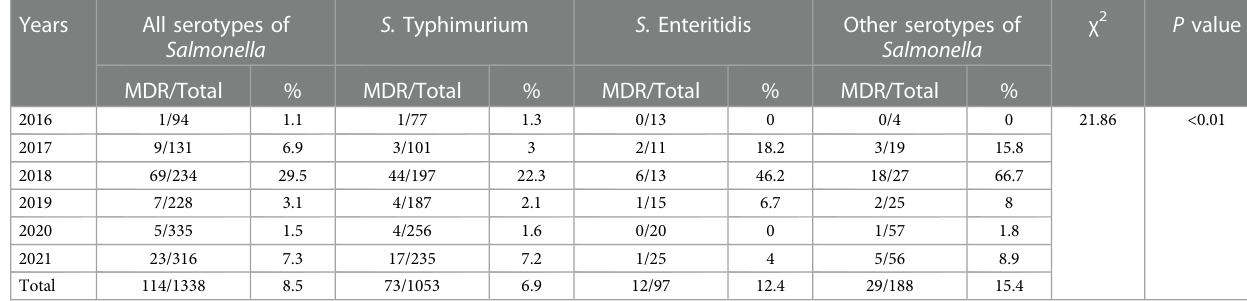
TABLE 5 Prevalence of multidrug-resistant (MDR) Salmonella isolates from 2016 to 2021. S. Typhimurium S. Years All serotypes of Salmonella